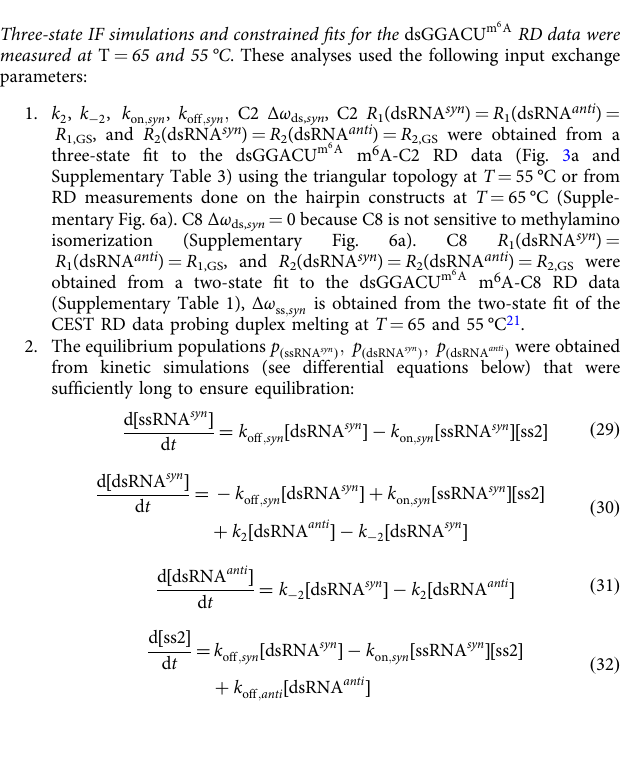
The same approach was used to simulate/ fi t CEST pro fi les for the IF pathway as described in the previous section. Four-state CS + IF simulations and constrained fi ts for the dsGGACU m 6 A RD data at T = 55 °C . These analyses used the following input exchange parameters: 1. All of the exchange parameters related to the CS pathway ( k 1 ; k (cid:1) 1 ; k on ; anti ; k